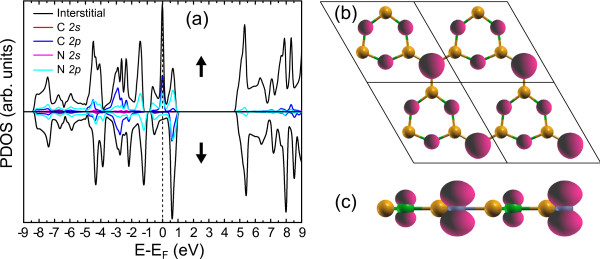
PDOS and spin density forβ-g-B3N3C.(a) PDOS on the interstitial region and on the 2s and 2p orbitals of C and N atoms in β-g-B3N3C. (b) The 3D iso-surface plot of spin density for the 2×2 supercell at the value of 0.04 e/Å3. (c) A side view of spin density corresponding to (b).